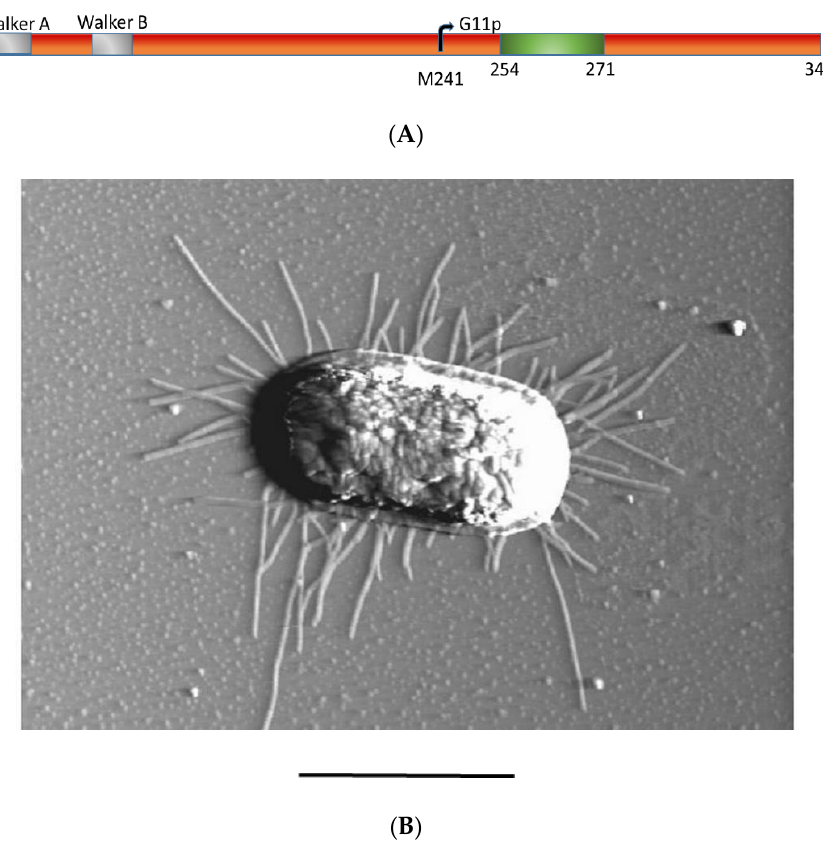
Figure 1. The secretion of M13 phage by E. coli is mediated by the M13 assembly machine. ( A ) Schematic representation of the G1p protein regions with the indicated Walker box sequences (grey, residues 8 to 15 and 84 to 89), the internal start codon M241 for G11p and the membrane anchor segment (green, 254 to 271) and the periplasmic domain (residues 272 to 348). ( B ) An M13-secreting E. coli cell 10 min post-infection was visualized by atomic force microscopy (AFM). The bar represents 1 µ m.